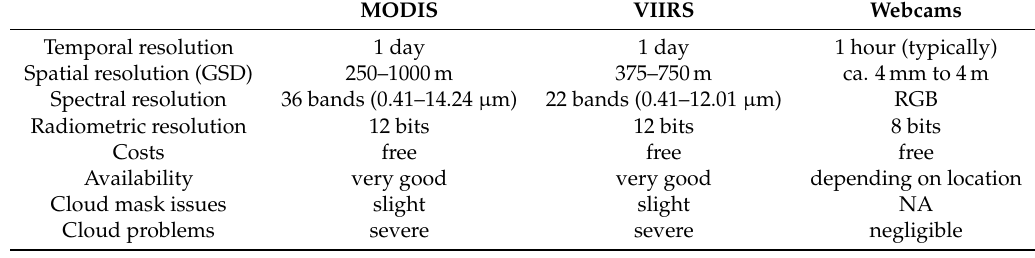
Table 3. Parameters of the used data (GSD = Ground Sampling Distance).